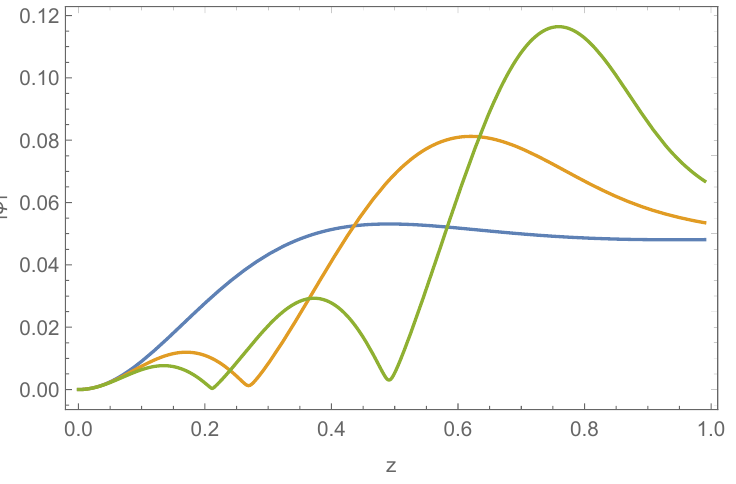
Figure 6 . The first three eigenfunctions ψ of the linearized equation of motion of the scalar field for Q = 3 . 4 and q = 6